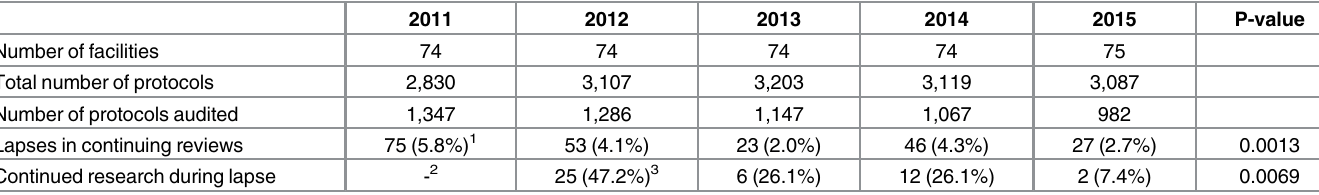
Table 1. Lapse in institutional animal care and use committee continuing reviews.